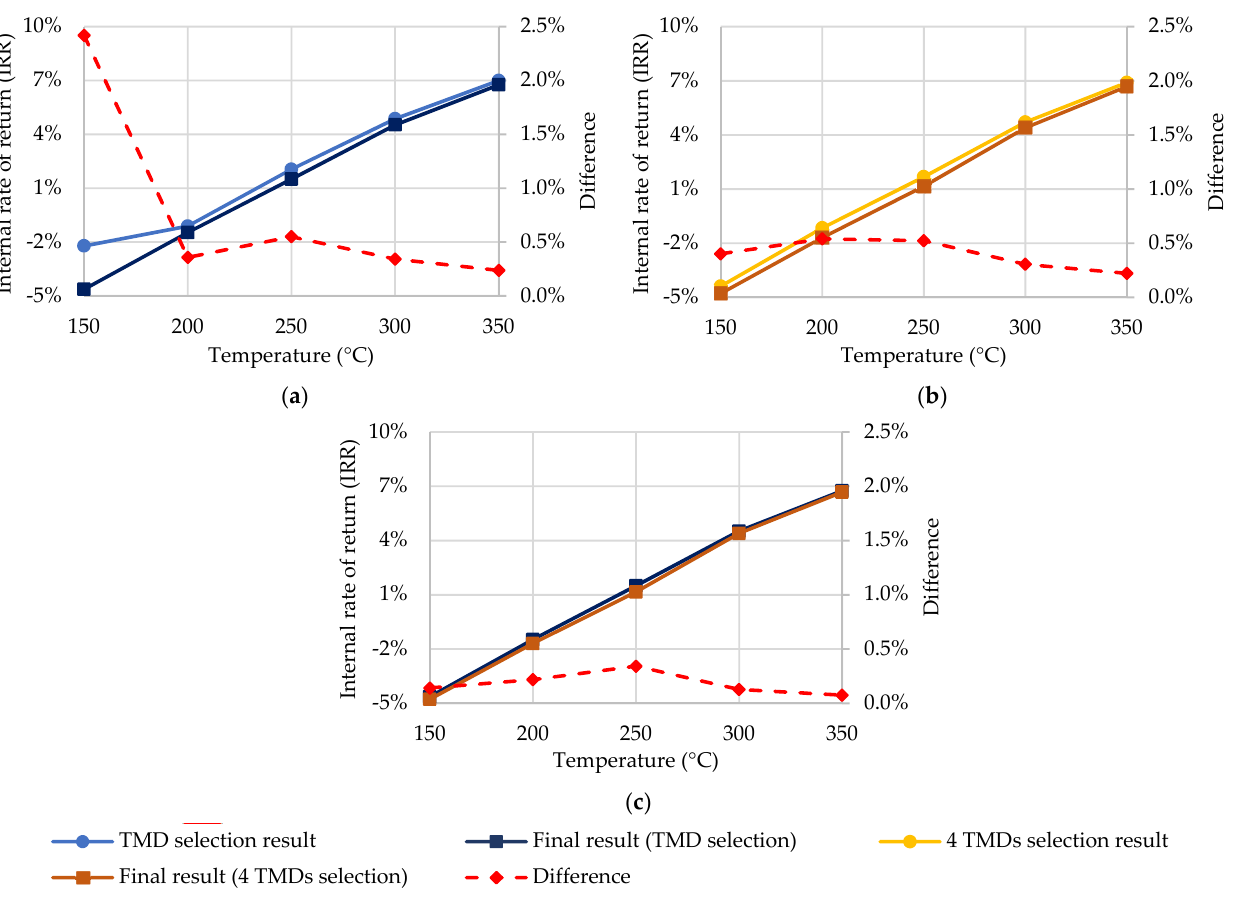
Figure 6. Comparison between the IRRs of the optimized plants for ( a ) a single TMD and ( b ) four TMDs and (c) the TMY for results for a single TMD and four TMDs. All in all, heliothermic technologies were still not economically competitive in the studied cases and presented negative IRRs. On the other hand, the optimized ORCs seemed to be very competitive, depending on the waste heat characteristics.